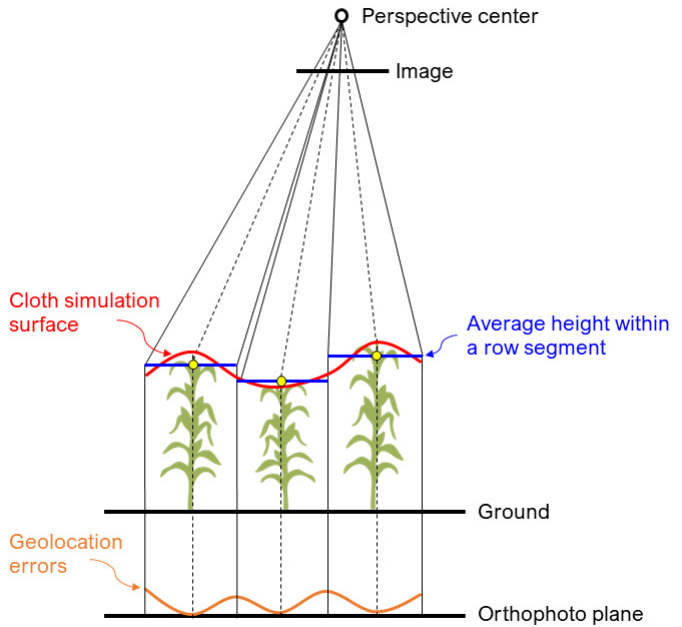
Figure 12. An illustration of the smooth DSM using the average elevation within a row segment based on cloth simulation, together with the expected geolocation error.